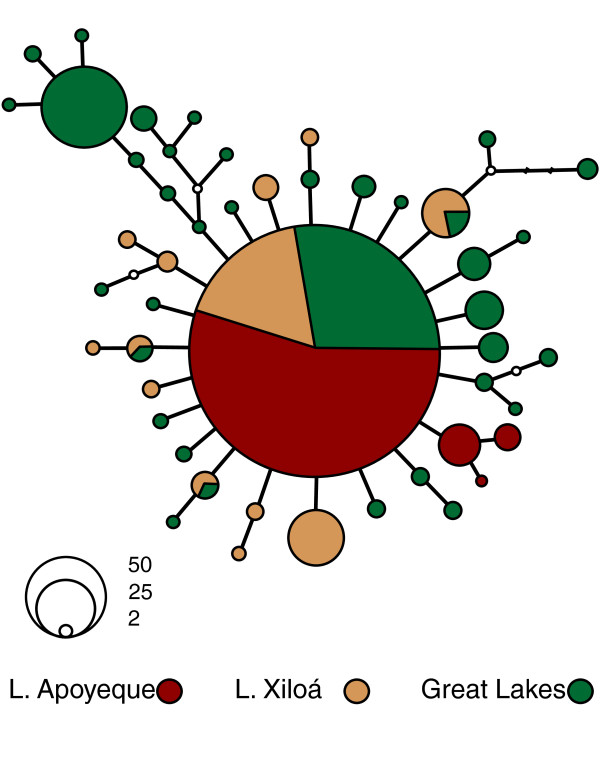
A haplotype network of mtDNA sequences show that the most common haplotype in Midas cichlids is also the most common haplotype in Apoyeque. Apoyeque has three haplotypes that are not shared with any other locality. Singleton haplotypes were included in the analysis but are not shown, except for one singleton from Apoyeque. Open circles represent missing or inferred haplotypes.